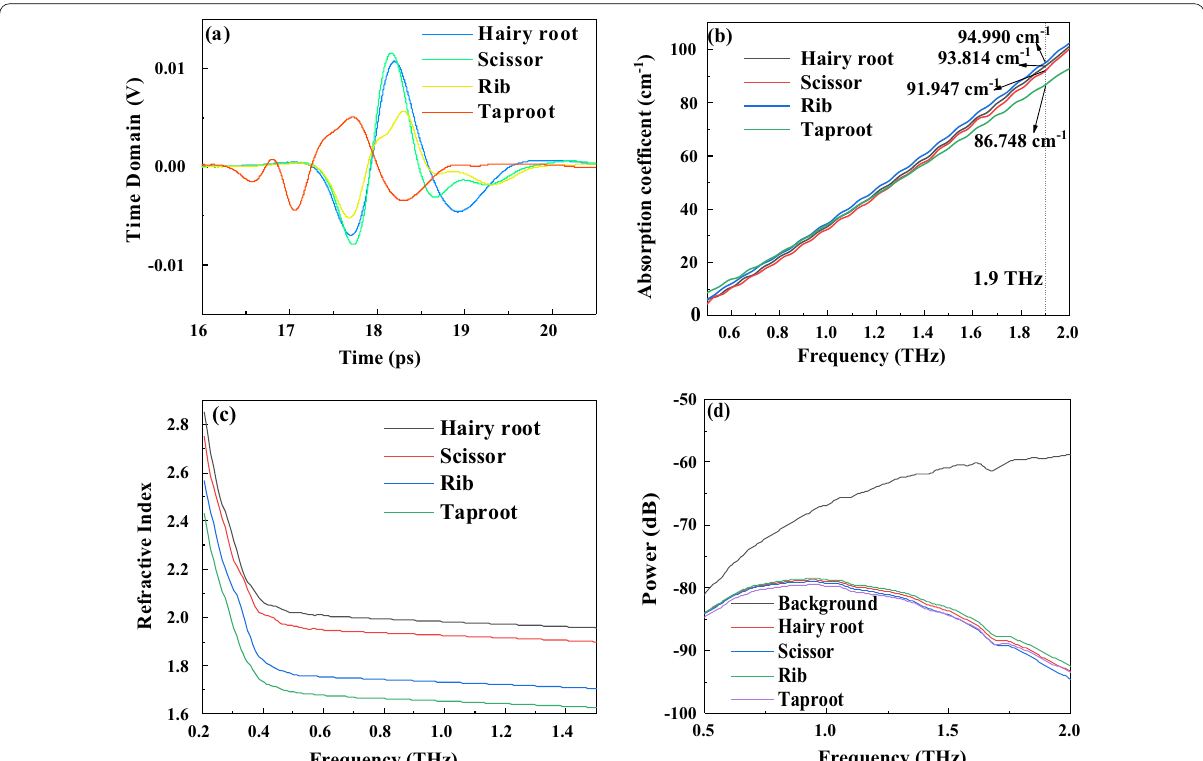
Fig. 1 THz spectra of four different parts, a is time‑domain spectroscopy; b is absorption coefficient spectrum in 0.5–2 THz; c is refractive Index in 0.2–1.5 THz; and d is frequency domain in 0.5–2